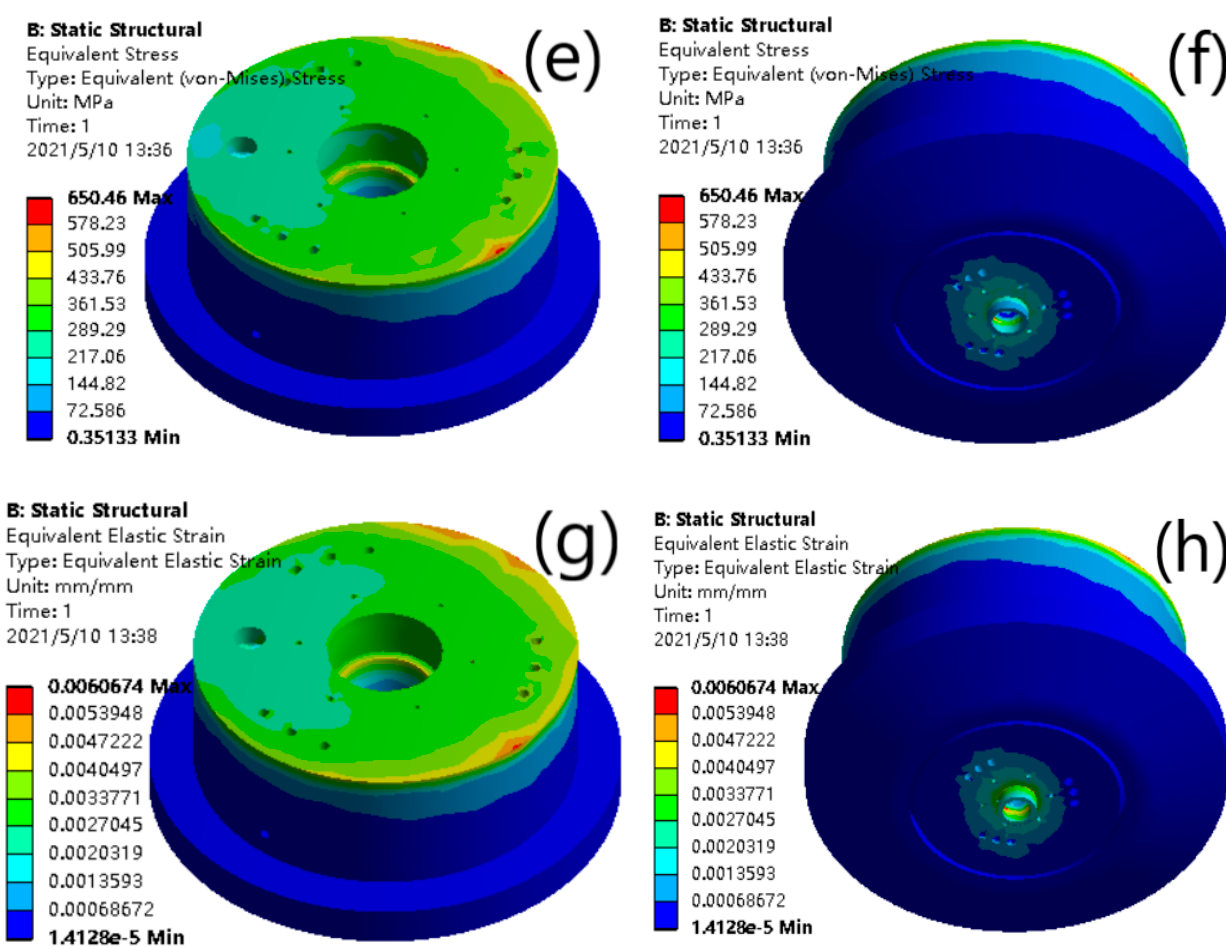
Figure 5. Simulations on the effect of water cooling. ( a ) Vertical view of steady-state thermal; ( b ) bottom view of steady-state thermal; ( c ) vertical view of total deformation; ( d ) bottom view of total deformation; ( e ) vertical view of equivalent stress; ( f ) bottom view of equivalent stress; ( g ) vertical view of equivalent elastic strain; and ( h ) bottom view of equivalent elastic stress.